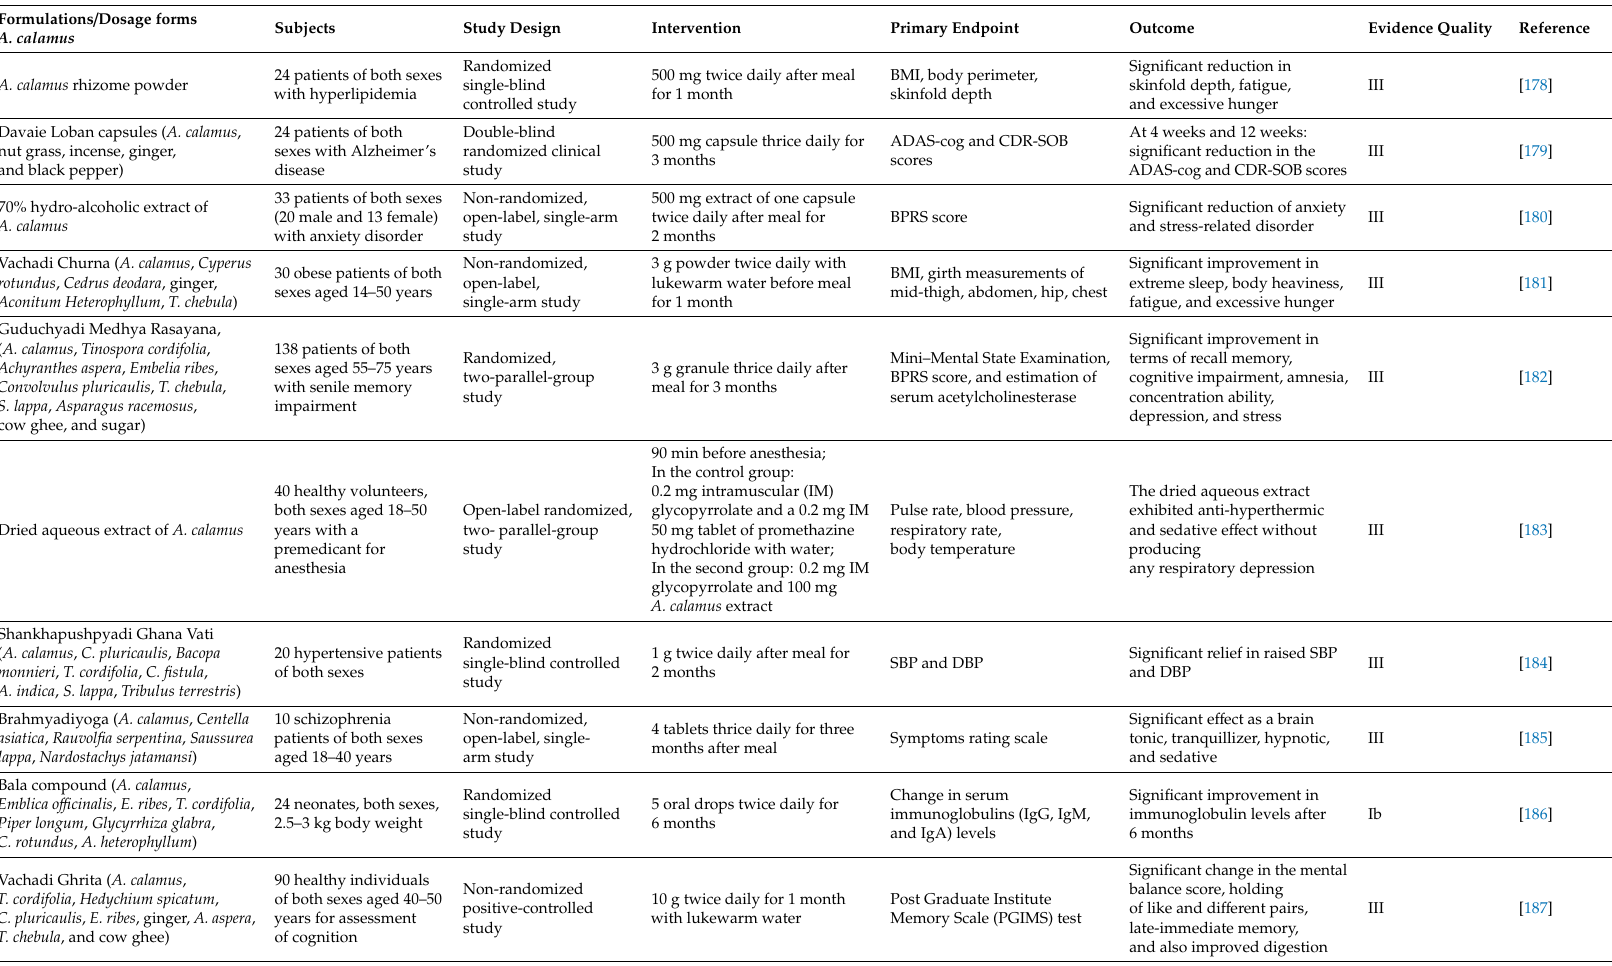
Table 5. Clinical claims of A. calamus in neurological and metabolic